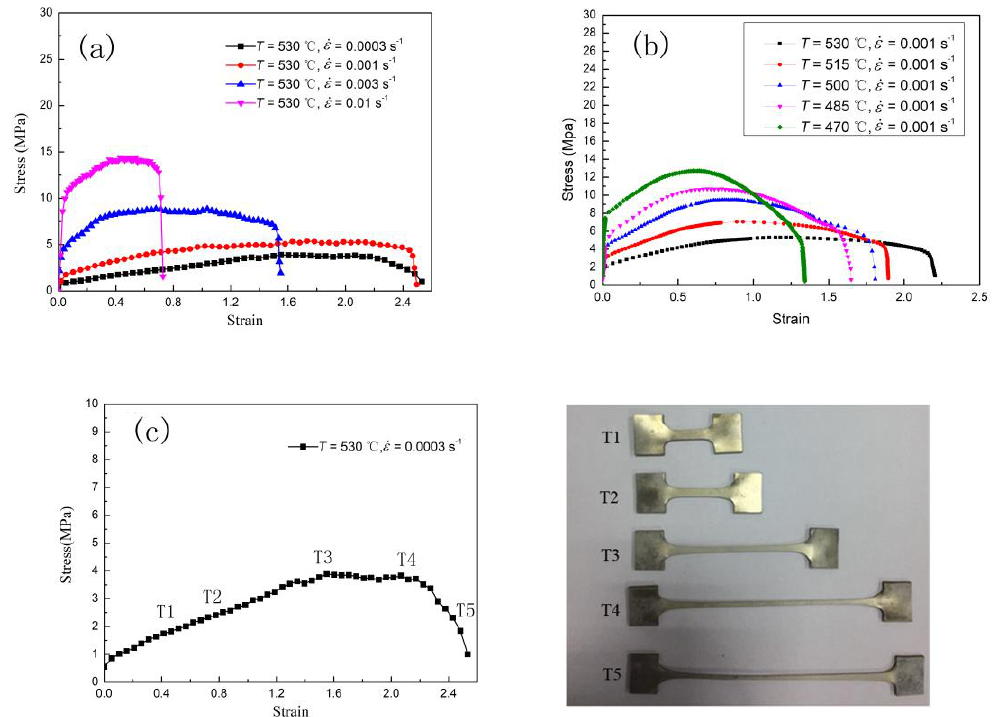
Figure 1. The curves of flow stress at ( a ) different strain rates at the same temperature and ( b ) different temperatures at the same strain rate. ( c ) The stress-true strain curve at 530 °C, 3 × 10 − 4 s − 1 and sample photos after each tensile stage marked with T1, T2, T3, T4 and T5, respectively.